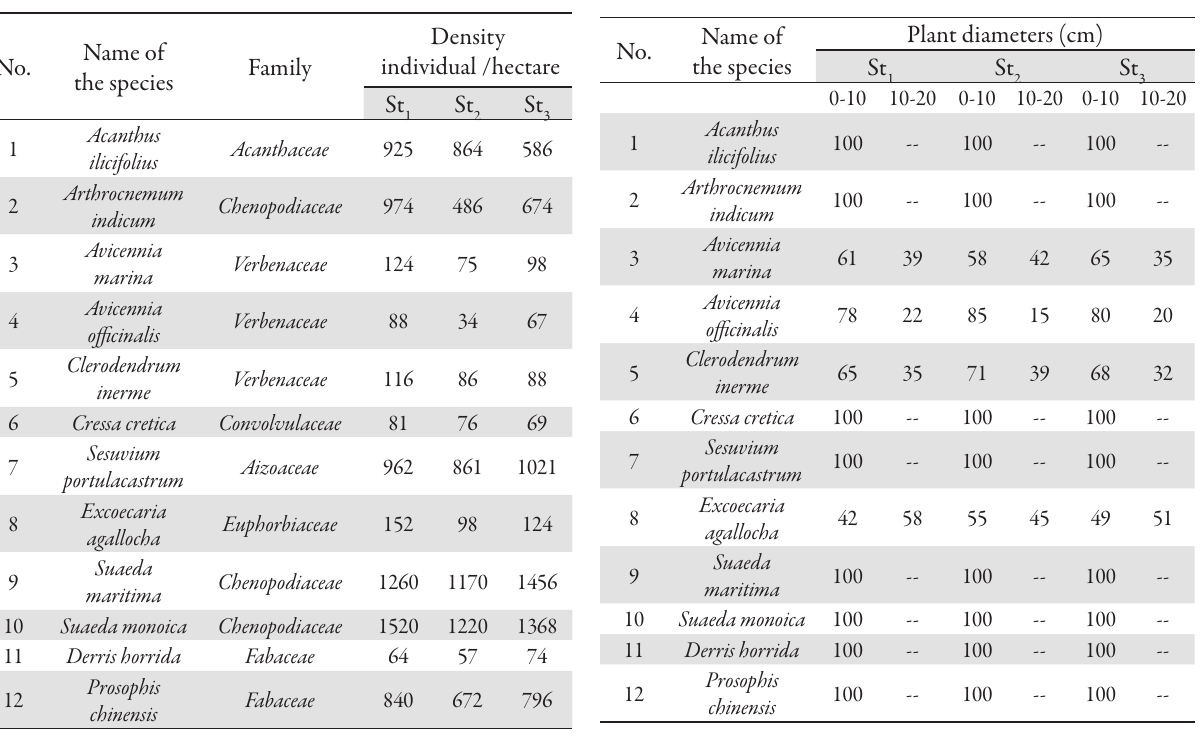
Tab. 3. Percentage frequency of DBH classes for mangroves